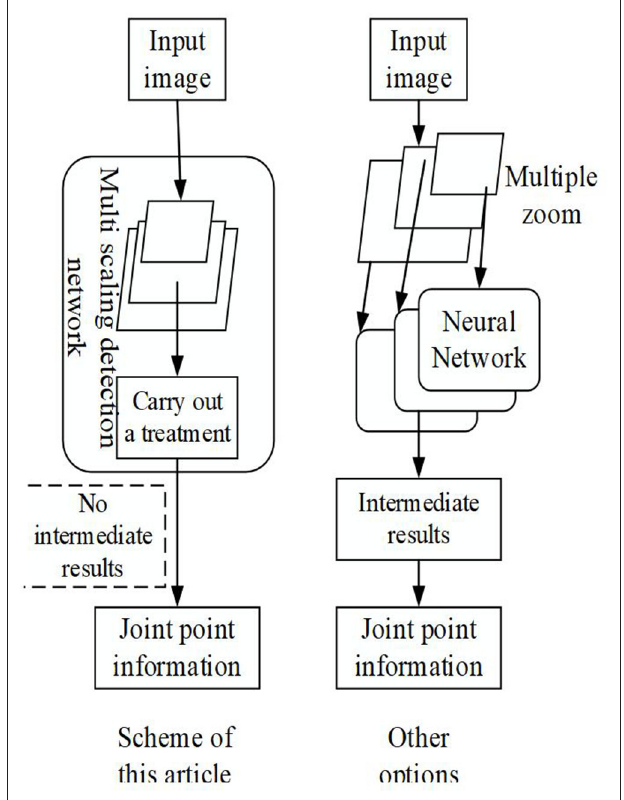
FIGURE 1 | The algorithm framework proposed and the previous scheme. FIGURE 2 | Modeling of human body